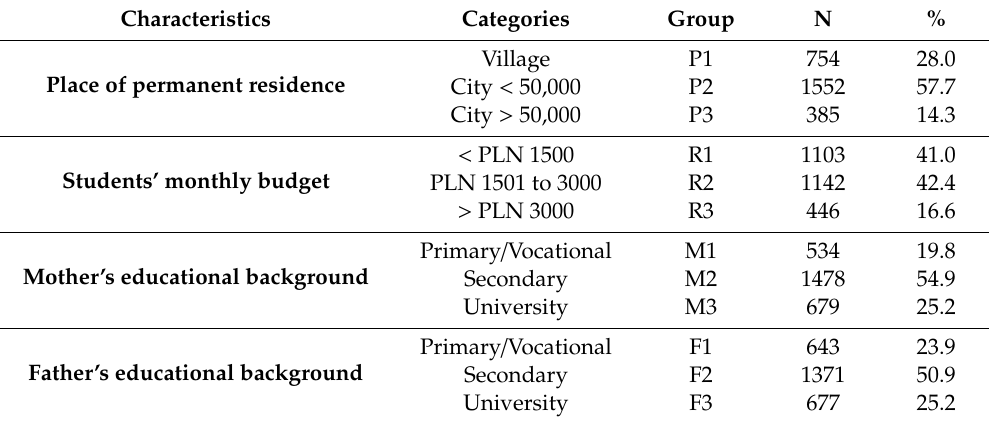
Table 1. The socioeconomic characteristics of the evaluated university